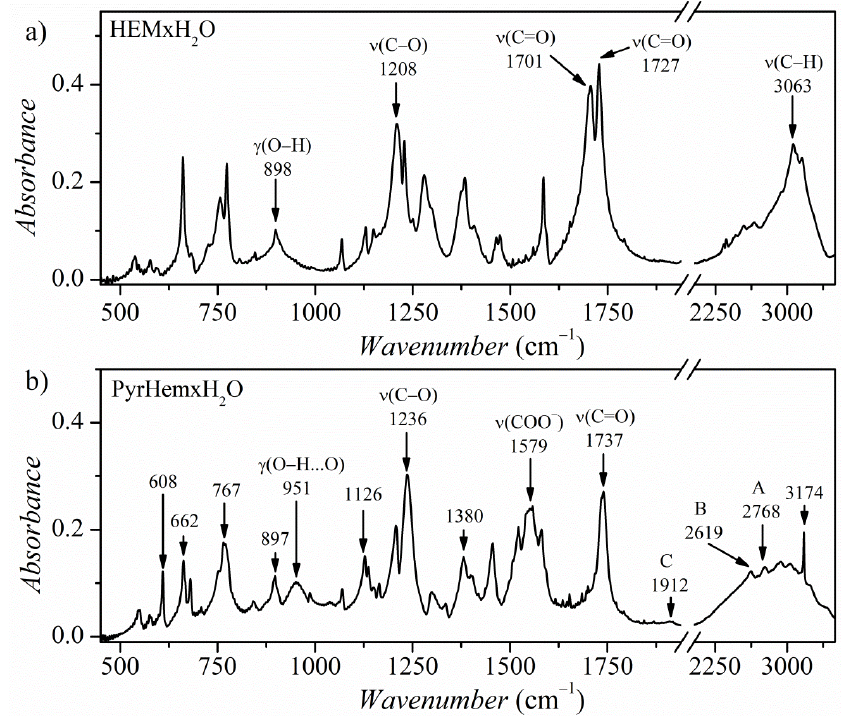
Figure 10. FT-IR absorption spectra of the HemxH 2 O ( a ) and PyrHemxH 2 O ( b ) recorded at 293